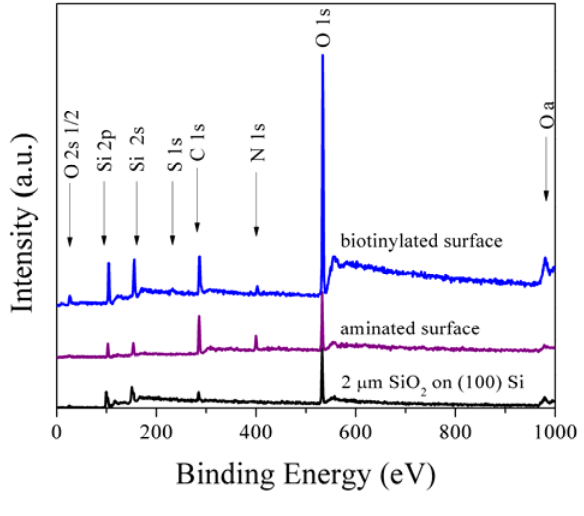
Figure 7. Chemical composition of control surfaces after each reaction step (using O plasma etching and vapor deposition